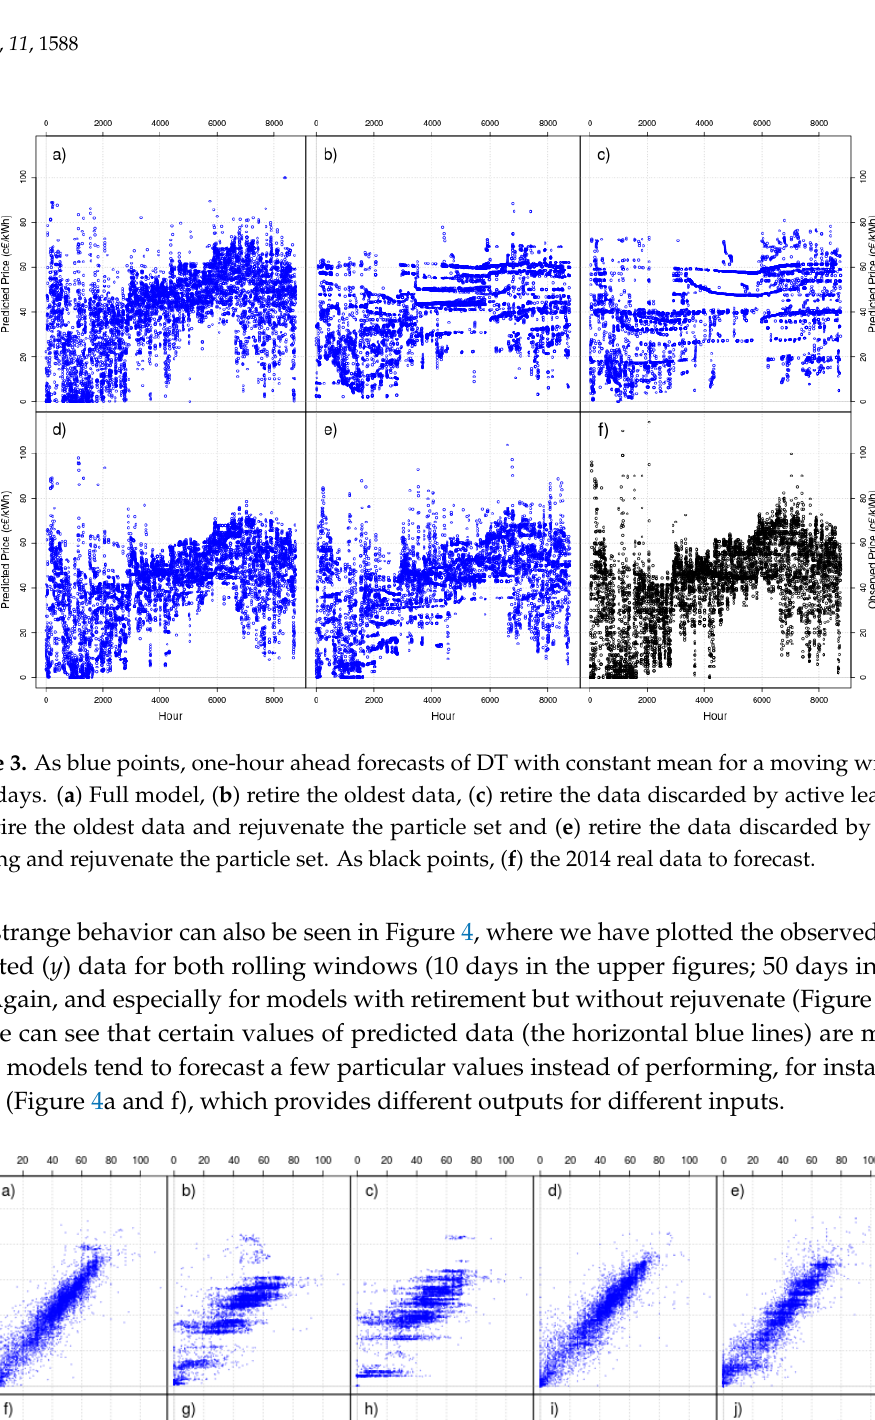
Figure 2. As blue points, one-hour ahead forecasts of Dynamic Trees (DT) with constant mean for a moving window of 10 days. ( a ) Full model, ( b ) retire the oldest data, ( c ) retire the data discarded by active learning, ( d ) retire the oldest data and rejuvenate the particle set and ( e ) retire the data discarded by active learning and rejuvenate the particle set. As black points, ( f ) the 2014 real data to forecast.